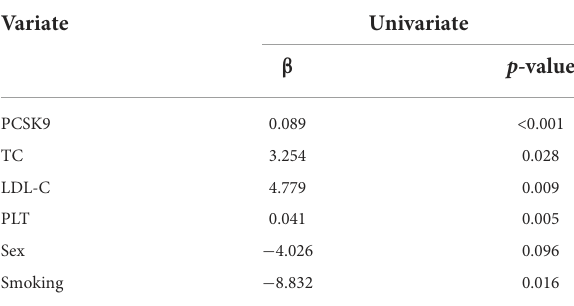
TABLE 1 Univariate linear regression analysis regarding the association of ADP-induced MAR and